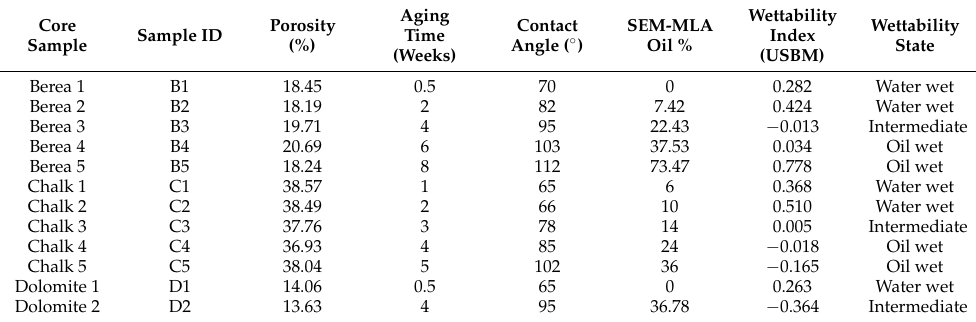
Table 1. Experimental measurement of wettability by contact angle, SEM-(MLA) and United States Bureau of Mines (USBM) method for Berea, chalk and dolomite samples at different aging times. Core Sample